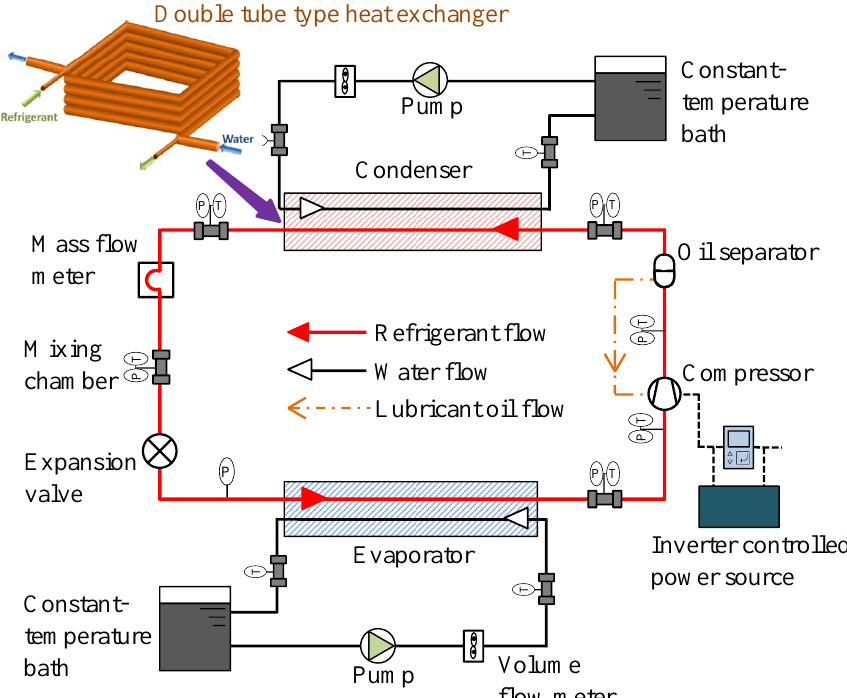
Figure 1. Prototype of a next-generation refrigerant performance study [76].